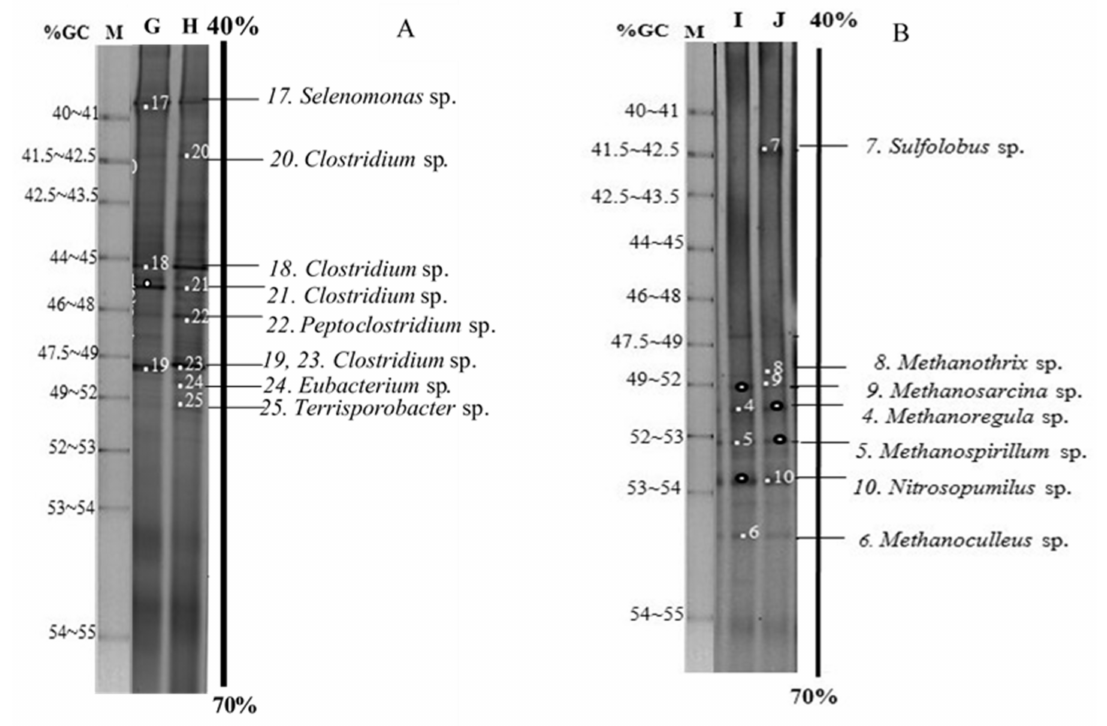
Figure 5. DGGE profiles of 16s rDNA fragments for the bacterial ( A ) and archaeal ( B ) species after hydrogen and methane production from the codigestion of crude glycerol with algal biomass at the optimum lanes: G, I and low conditions lanes: H,